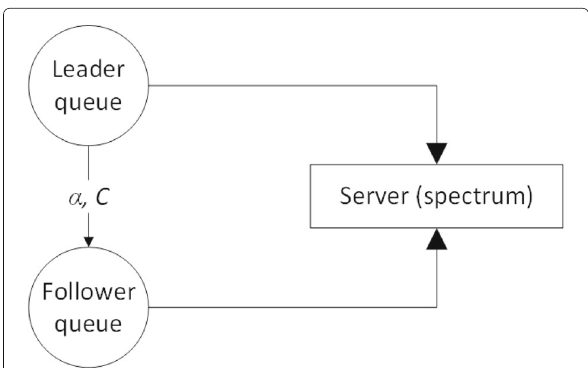
Fig. 1 Queuing model of primary user as a leader and secondary user as a follower in Stackelberg game